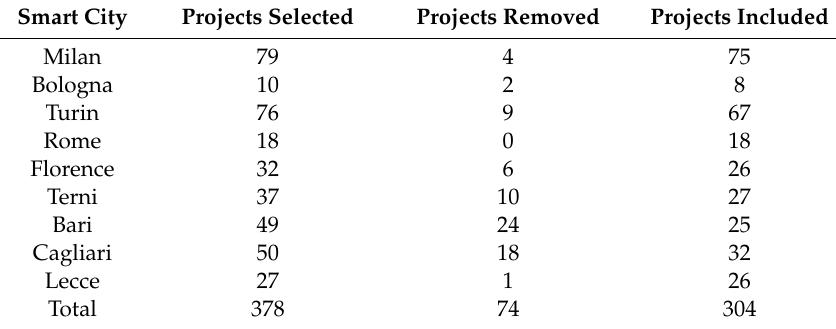
Table 2. Project distribution.